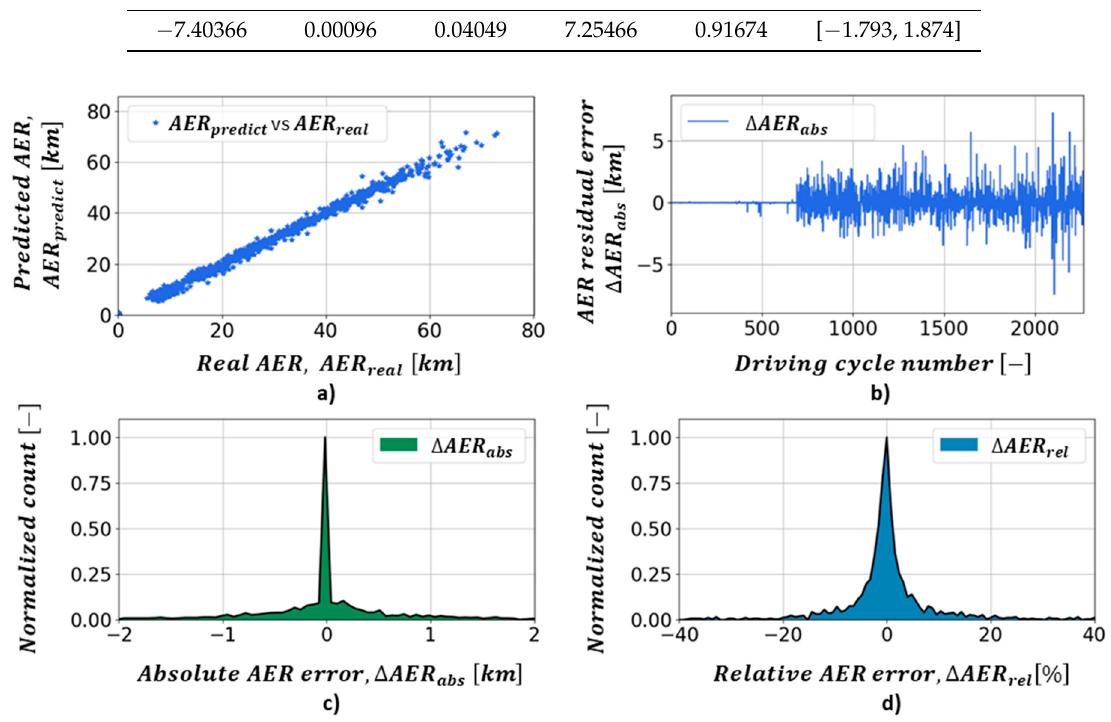
Figure 13. Predicted AER predict vs. real AER real values ( a ), absolute AER residuals ∆ AER abs for given testing input dataset ( b ), and distributions of absolute ( c ) and relative ( d ) predicted AER residuals.